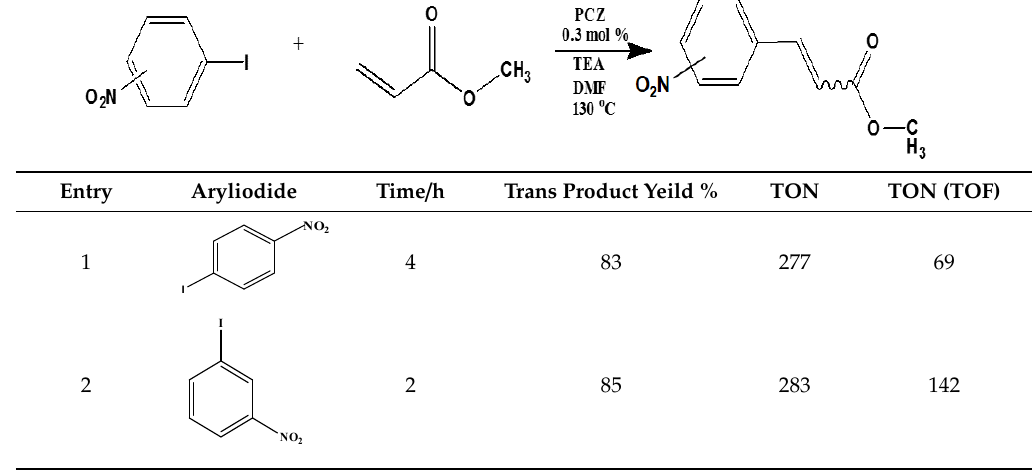
TON (TOFs) reported to trans product.